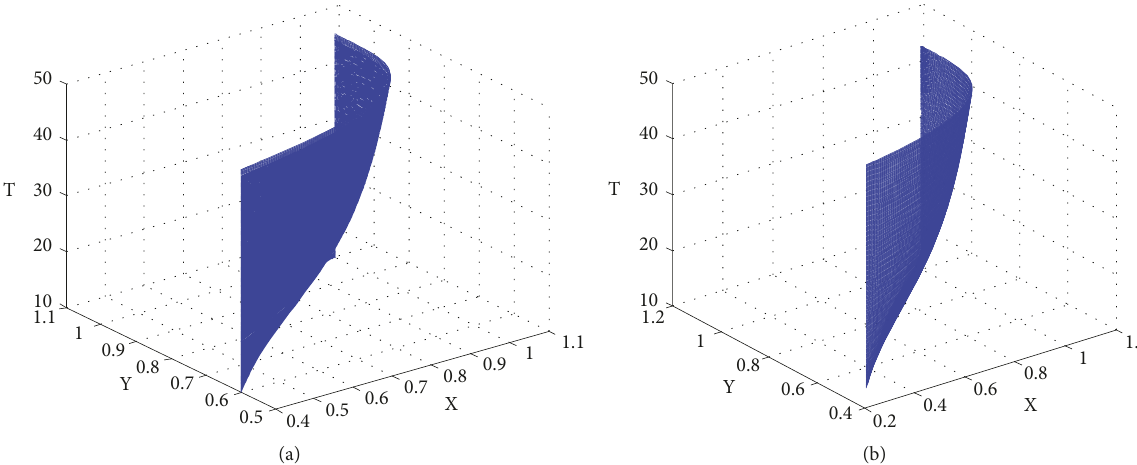
Figure 16: The change of 𝑇 with respect to the initial values of (0.4,0.6) and (0.3,0.5) in Scenario 2.